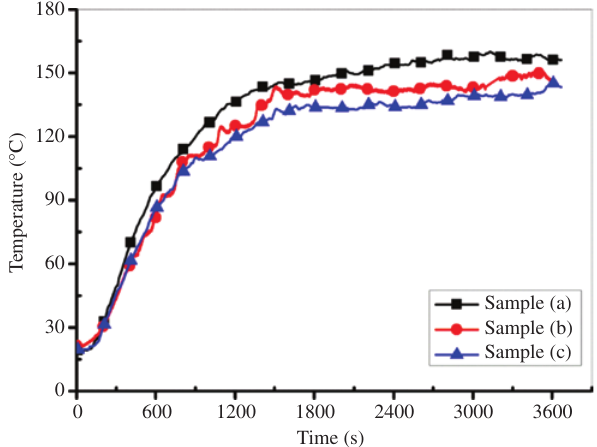
Figure 10: Temperature versus time at the face unexposed to fire.